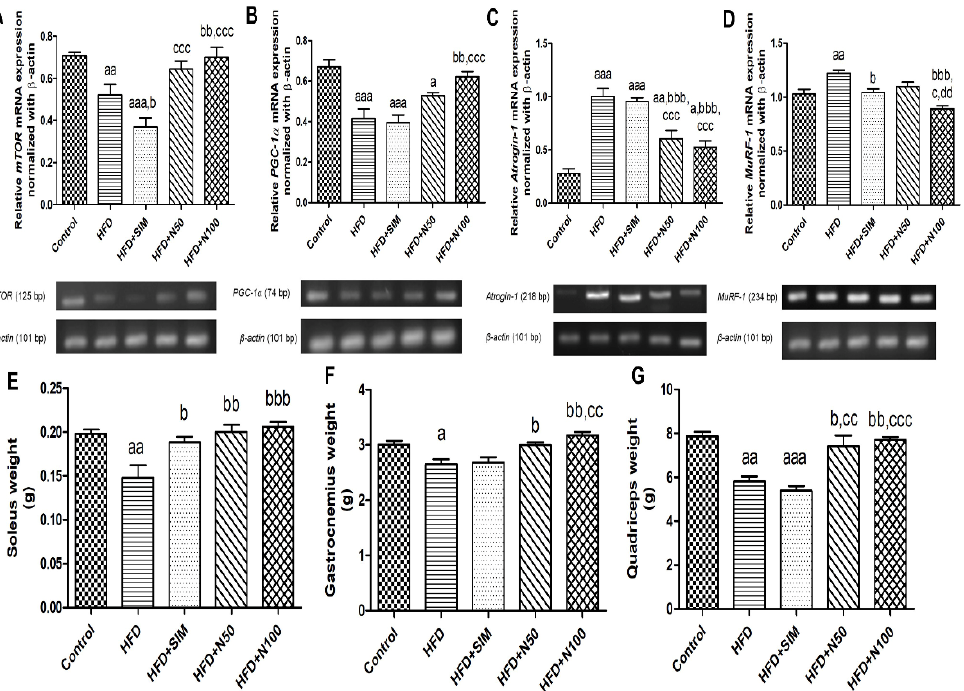
Figure 3. The effect of naringin on the mRNA expression of protein metabolism in the quadriceps of high-fat-diet-fed rats. Representative mRNA expression images of the quadriceps tissues. mTOR ( A ), PGC- 1α ( B ), Atrogin-1 ( C ), MuRF-1 ( D ). The results are shown as mean ± SE from a duplicate of at least 6 rats. The figures of the muscle weights of the soleus, gastrocnemius, and quadriceps tissues of the rats are shown as ( E – G ), respectively. The results are shown as mean ± SEM for 6 to 7 rats per group as: a p < 0.05, aa p < 0.01, and aaa p < 0.001 vs. the control group; b p < 0.05, bb p < 0.01, and bbb p < 0.001 vs. the HFD group; c p < 0.05, cc p < 0.01, and ccc p < 0.001 vs. the HFD + SIM group; and dd p < 0.01 vs. the HFD + N50 group.